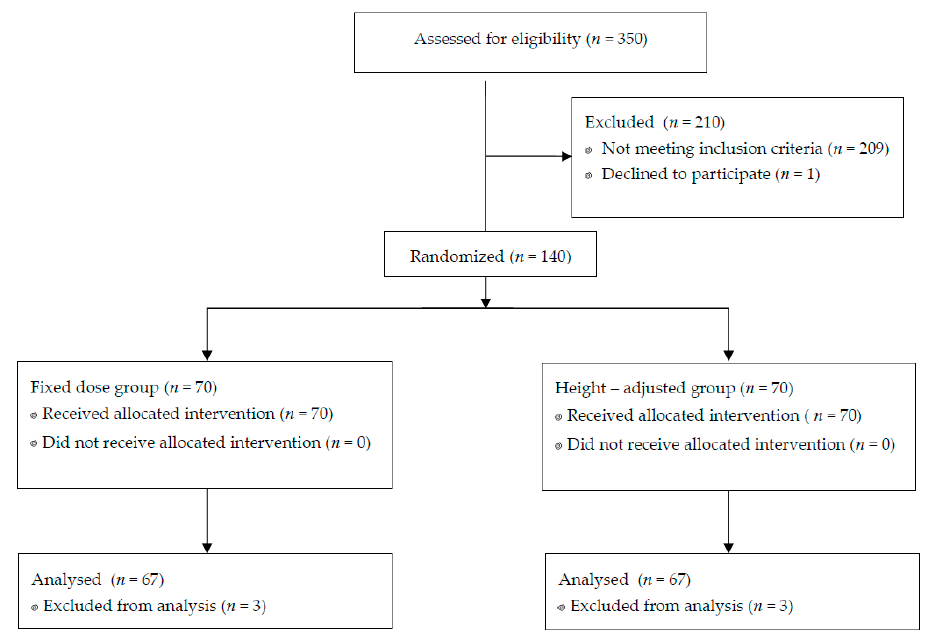
Figure 1. Consolidated Standards of Reporting Trials (CONSORT) flow diagram. Table 2. Demographic, obstetric and procedure-related